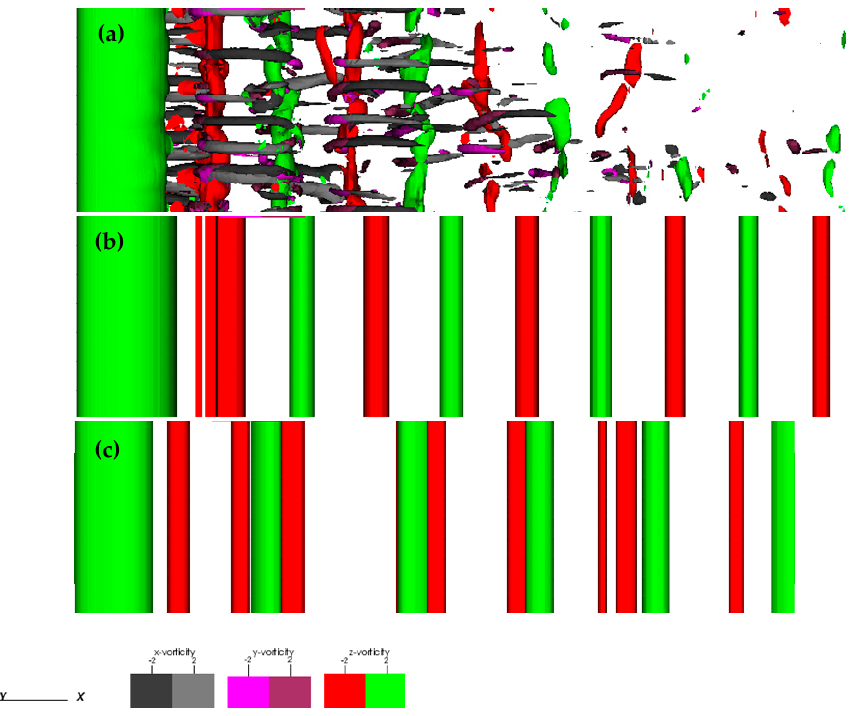
Figure 14. Clockwise cylinder oscillation: Instantaneous vorticity isosurfaces (top view) for F = 1.0 and ( a ) A y /D = 0.10, ( b ) A y /D = 0.20, ( c ) A y /D = 0.30.